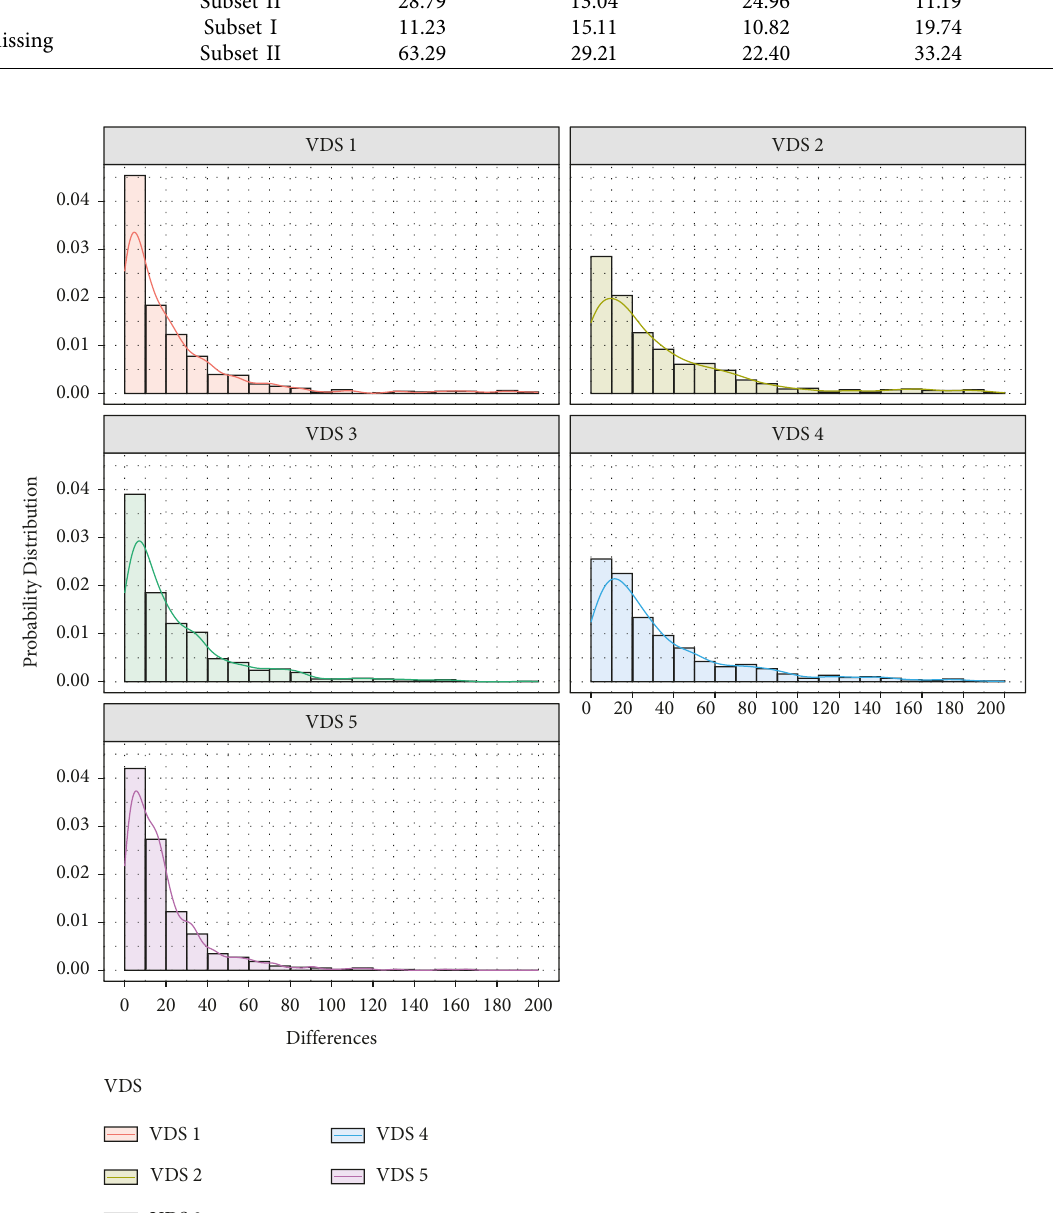
Figure 7: Probability distribution of the adjacent difference of traffic volume among